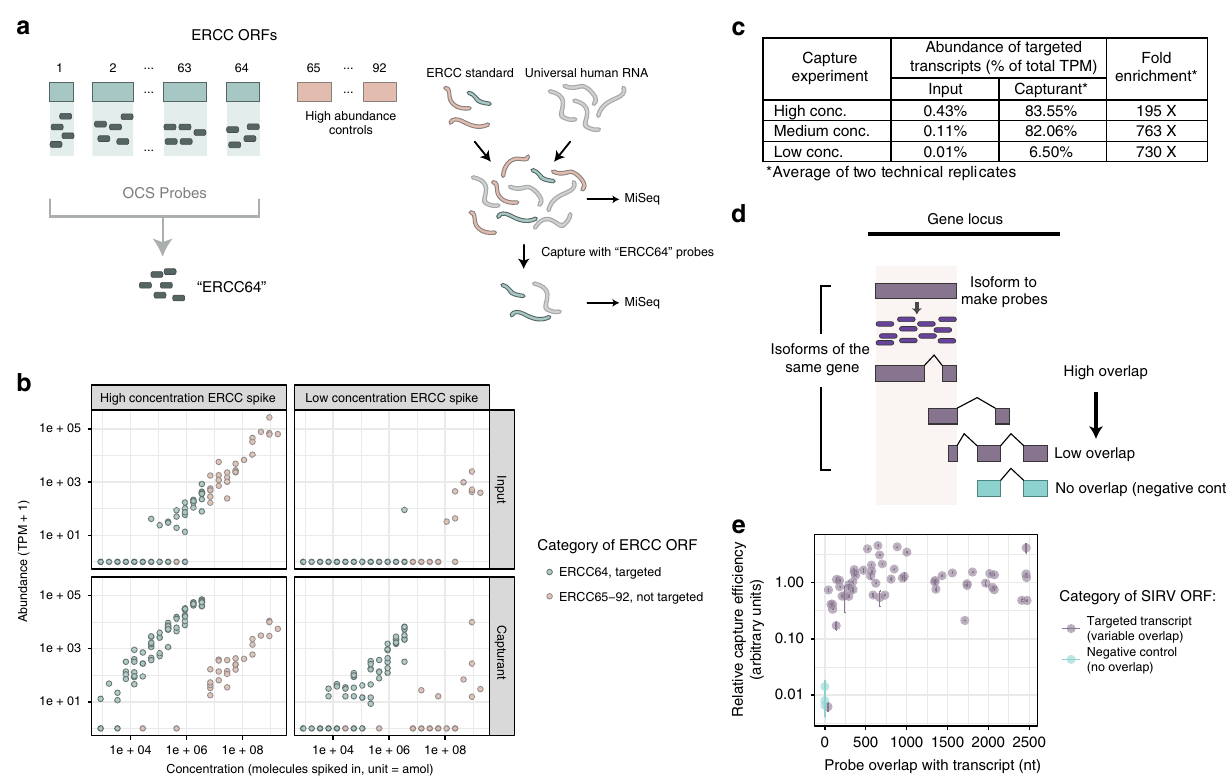
Fig. 2 Benchmarking OCS analytical performance. a Schematic of benchmarking experiment using ERCC standards. b Enrichment of ERCC targets. The x - axis represents the nominal concentration of ERCC RNAs spiked into the starting pool of RNA (input) and the y -axis represents estimated abundance of each ORF in the input cDNA (top row) or capturant (bottom row). Each point represents a distinct ERCC standard (92 in total) which was targeted (light blue) or not targeted (pink). c Summary statistics related to capture ef fi ciencies for ERCC capture reactions. d Schematic of probe synthesis using the SIRV system. e Relationship between enrichment ef fi ciencies at different isoform overlaps. The isoform overlap represents the absolute number of nucleotides overlapping between (i) the template isoform used to generate probes, and (ii) the target isoform present in the sample. Negative controls are non- overlapping isoforms. Capture ef fi ciencies were computed by dividing read depth of each SIRV (isoform) in capturant by the read depth in input cDNA. Error bars, standard deviation. Source data are available in the Source Data fi